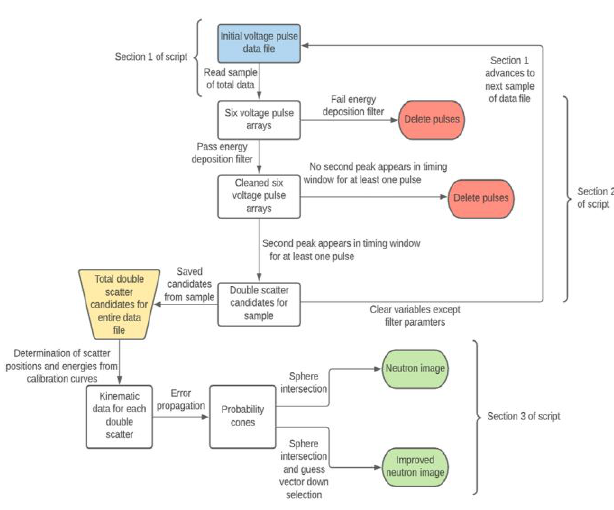
Fig. 6. Flowchart of data in the MATLAB script used in the algorithm that reads and processes neutron imaging data from the prototype simplified NSC.